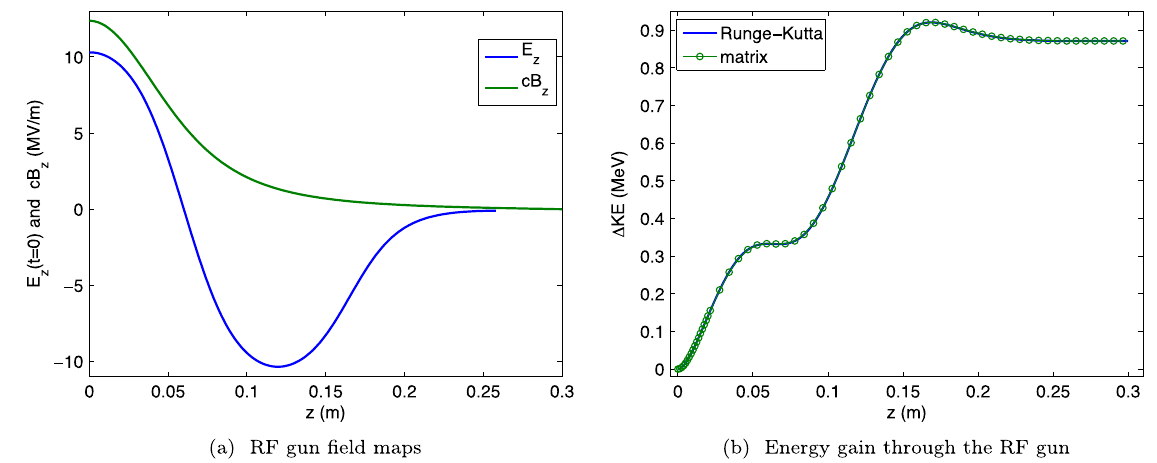
FIG. 5. The fields and energy gain for the rf gun setup. The cavity field is scaled so that the cavity voltage is 1 MV, and the phase is set to the on-crest value for a 1 MeV